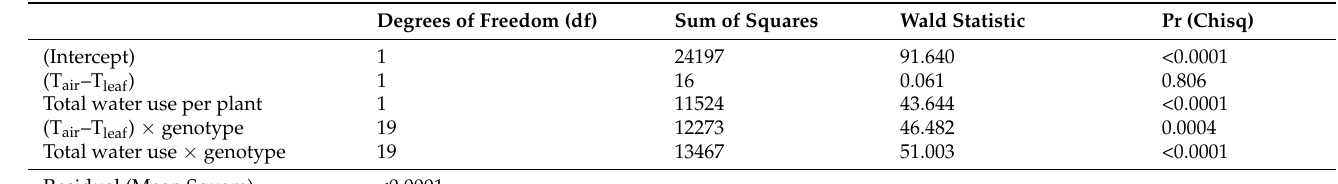
Table 4. Summary of the fixed effects of the linear mixed model used to evaluate the effect of total water use per plant and leaf-to-air temperature differential (T air –T leaf ) on biomass reduction% under high temperature conditions (T2).